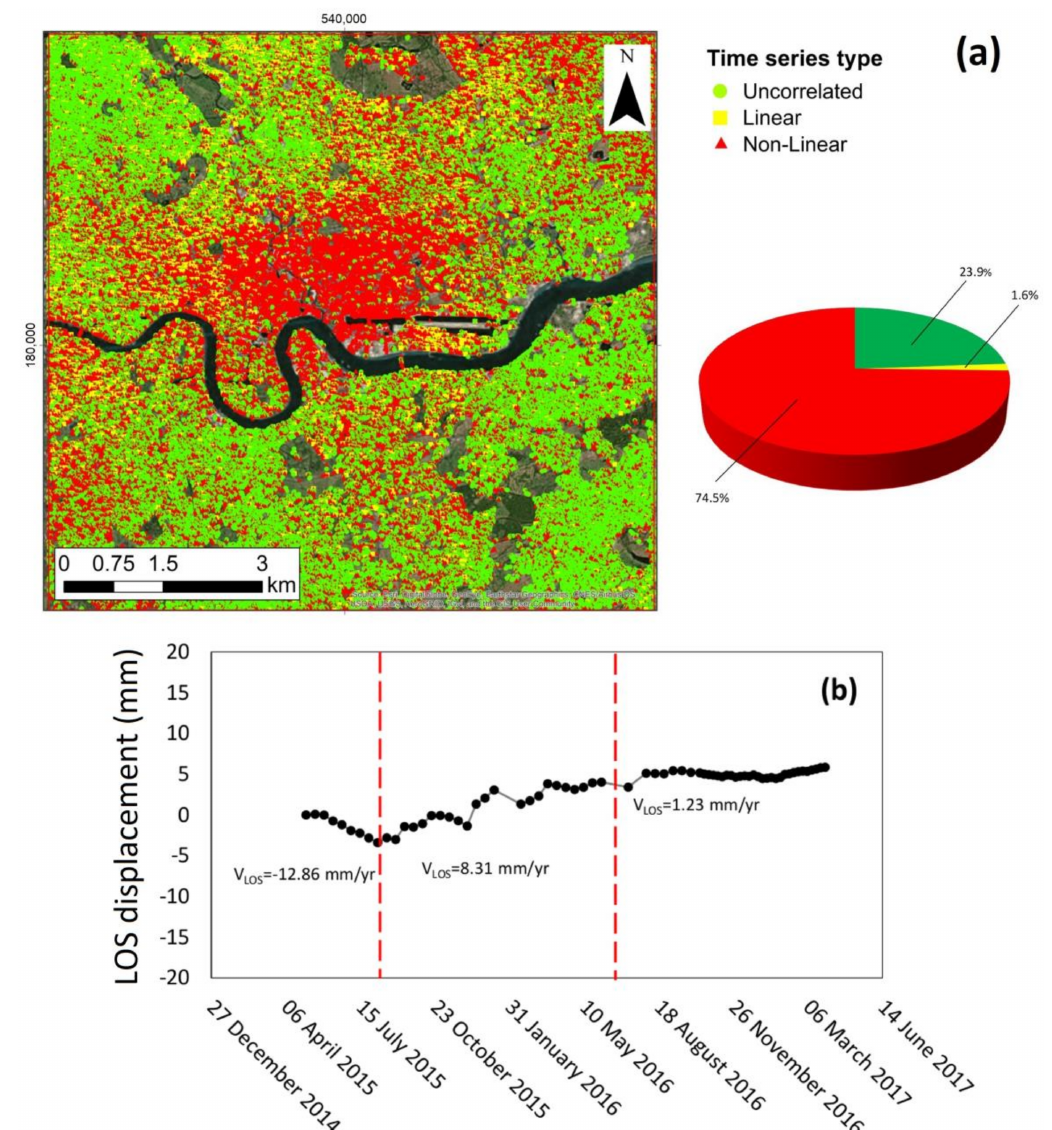
Figure 7. TS trends in the uplift zone ( a ). Average TS of the non-linear targets located in the uplift zone. The detected breaks (red dotted lines) are also reported ( b ). See the location of the uplift zone in Figure